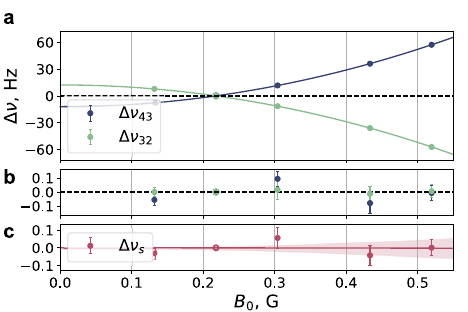
Fig. 3 Sensitivity of the clock “ 43 ” and “ 32 ” transitions and synthetic frequency to the bias magnetic fi eld value. a Frequency shifts Δ ν 43 and Δ ν “ main ” bias magnetic fi eld B m at a fi xed value of 32 as a function of the 0 ¼ 218 mG. Solid lines are parabolic fi ts to the the “ reference ” fi eld of B r 0 data. b Fit residuals. The synthetic frequency shift Δ ν s is shown in ( c ). The shaded area indicates the 1 σ = 0.175 Hz G − 2 uncertainty of the quadratic Zeeman coef fi cient. Error bars correspond to 1 s.d. statistical uncertainty.